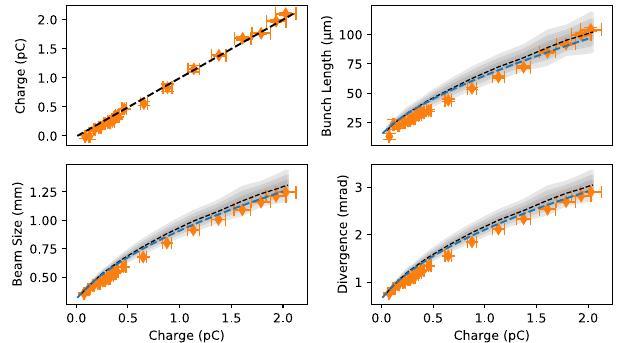
11. Prediction results for other charge dependent beam parameters. The black dashed line denotes the mean ASTRA simulation result. The shaded areas correspond to the 1, 2, and 3 σ uncertainty of the simulation, based on 100 simulations with normally distributed input parameters. The blue dashed line corresponds to an ASTRA simulation using the mean predicted laser spot size and pulse length (see Table